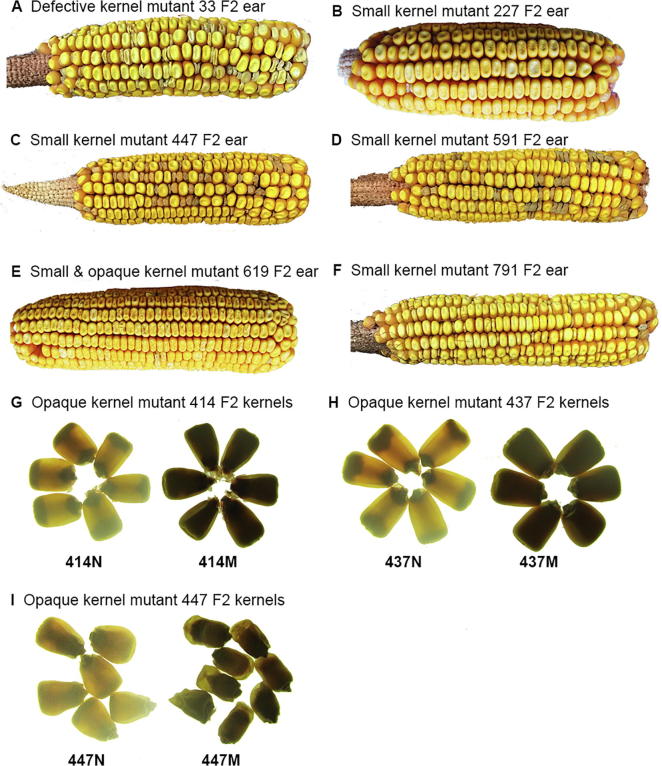
Kernel phenotypes in mutants 33 (A), 227 (B), 447 (C), 591 (D), 619 (E), 791 (F), 414 (G), 437 (H), and 447 (I)